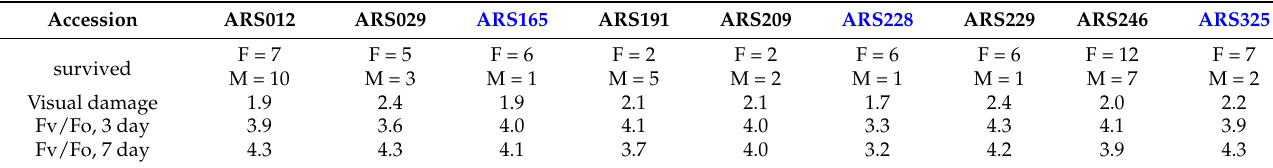
Table 4. Summary of genotypic determination of winter canola/rapeseed plants that survived the 2019–2020 winter in Fargo, ND (F) and Morris, MN (M). A distance matrix for the overwintered canola/rapeseed individuals (Supplemental Table S4) was used to identify genotypes. The values for visual damage scale and chlorophyll fluorescence (Fv/Fo) were determined previously [19,20]. Accessions in black color were from the top 10 freezing tolerant accessions from a KSU population [19], and those in blue color represent other accessions among the total winter rapeseed population (621